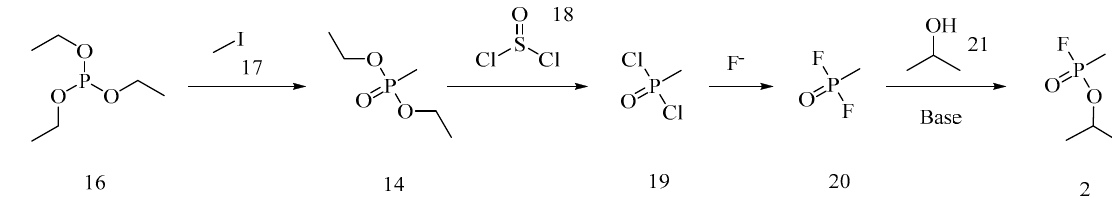
Scheme 1. Synthetic relationship of scheduled chemicals.